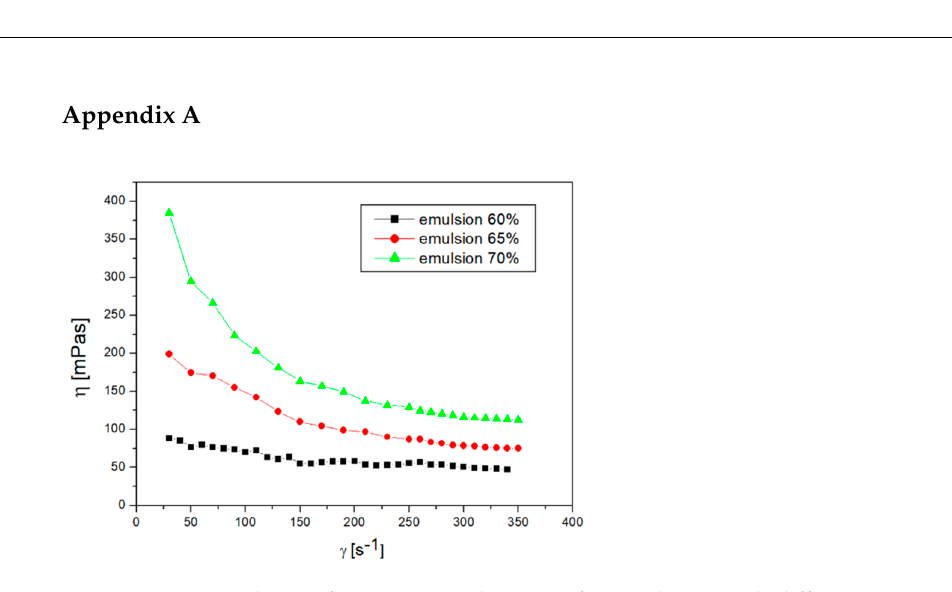
Figure A1. Dependence of viscosity on shear rate for emulsions with different concentrations of internal phase.